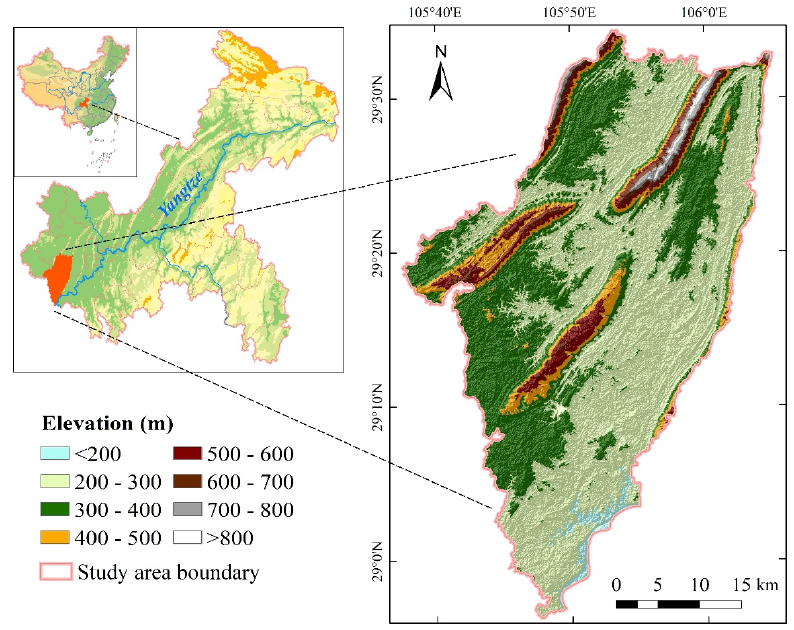
Figure 1. The location of the study area and its digital elevation model (DEM).